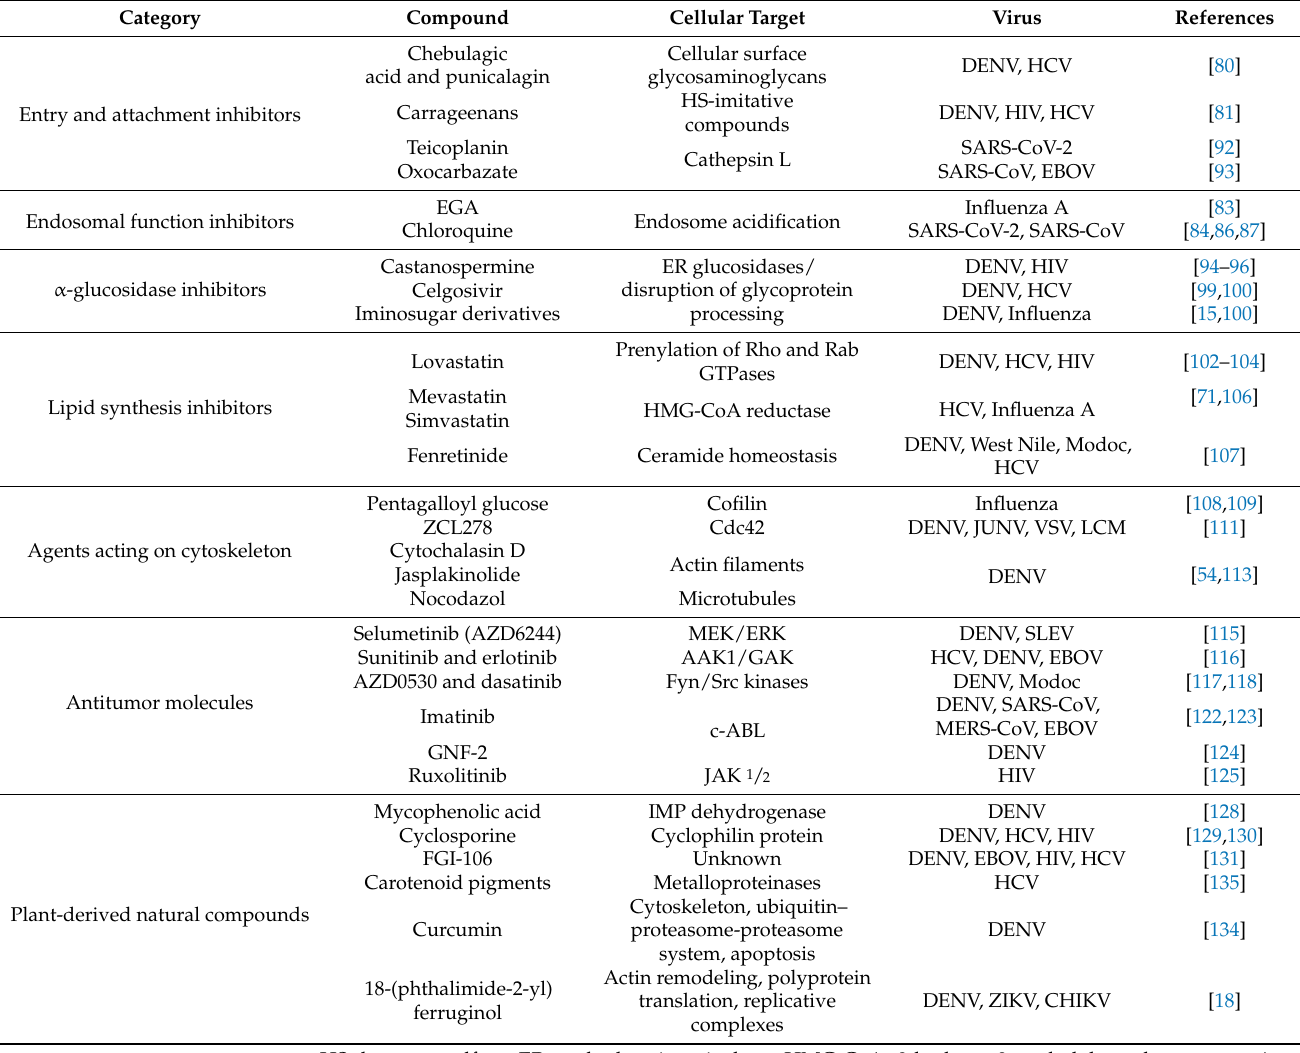
Table 1. Host-targeted antivirals against some RNA